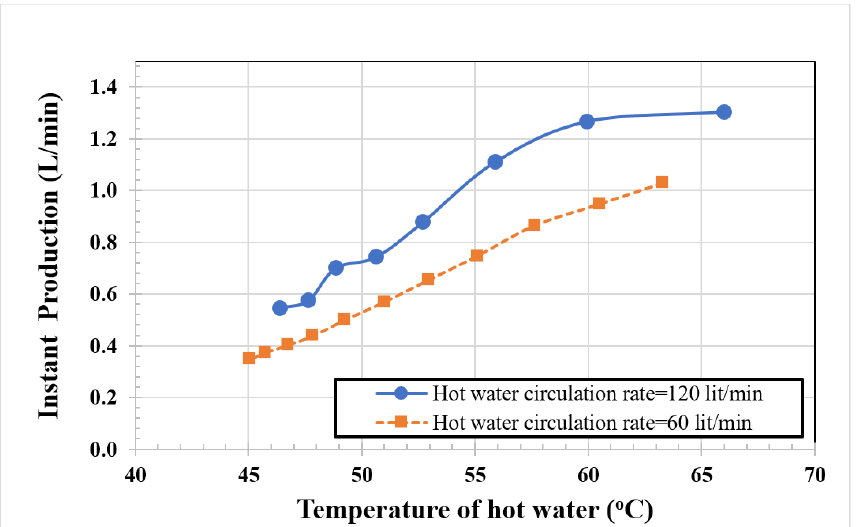
Figure 13. Instantaneous production of fresh water versus the temperature of the seawater at two different levels of hot seawater circulation rate.